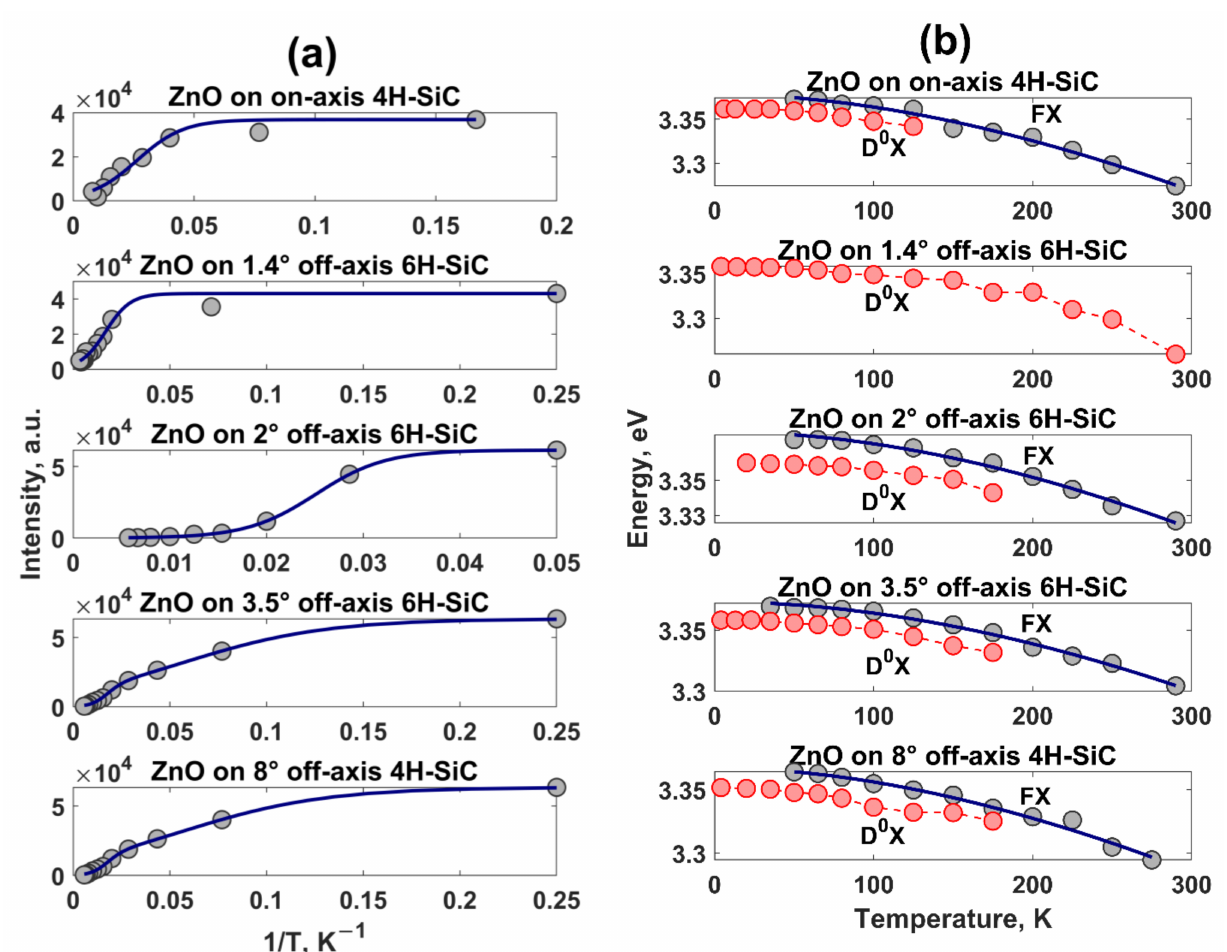
Figure 6. ( a ) The intensity of donor-to-bound excitons (D 0 X) emission peak as a function of inverse temperature (filled gray circles) and corresponding fitting solid blue curves (Equations (2) and (3)) for ZnO films grown on SiC substrates with different off-cut angles. The goodness of Arrhenius fit (R 2 ) is predicted to be 0.9519, 0.9648, 0.9998, 0.9996, and 0.9999 for ZnO films on 0 ◦ -6H-SiC, 1.4 ◦ -6H-SiC, 2 ◦ -6H-SiC, 3.5 ◦ -6H-SiC, and 8 ◦ -4H-SiC, respectively. ( b ) The energy position of the FX peak (filled gray circles) as a function of temperature and the corresponding fitting solid blue curves (Equation (4)). The goodness of Varshni fit (R 2 ) is predicted to be 0.9891, 0.9898, 0.9937, and 0.9842 for ZnO films on 0 ◦ -6H-SiC, 2 ◦ -6H-SiC, 3.5 ◦ -6H-SiC, and 8 ◦ -4H-SiC, respectively. We also depicted the temperature dependence of the D 0 X emission peak. The off-axis angle increases from the top panel to the bottom